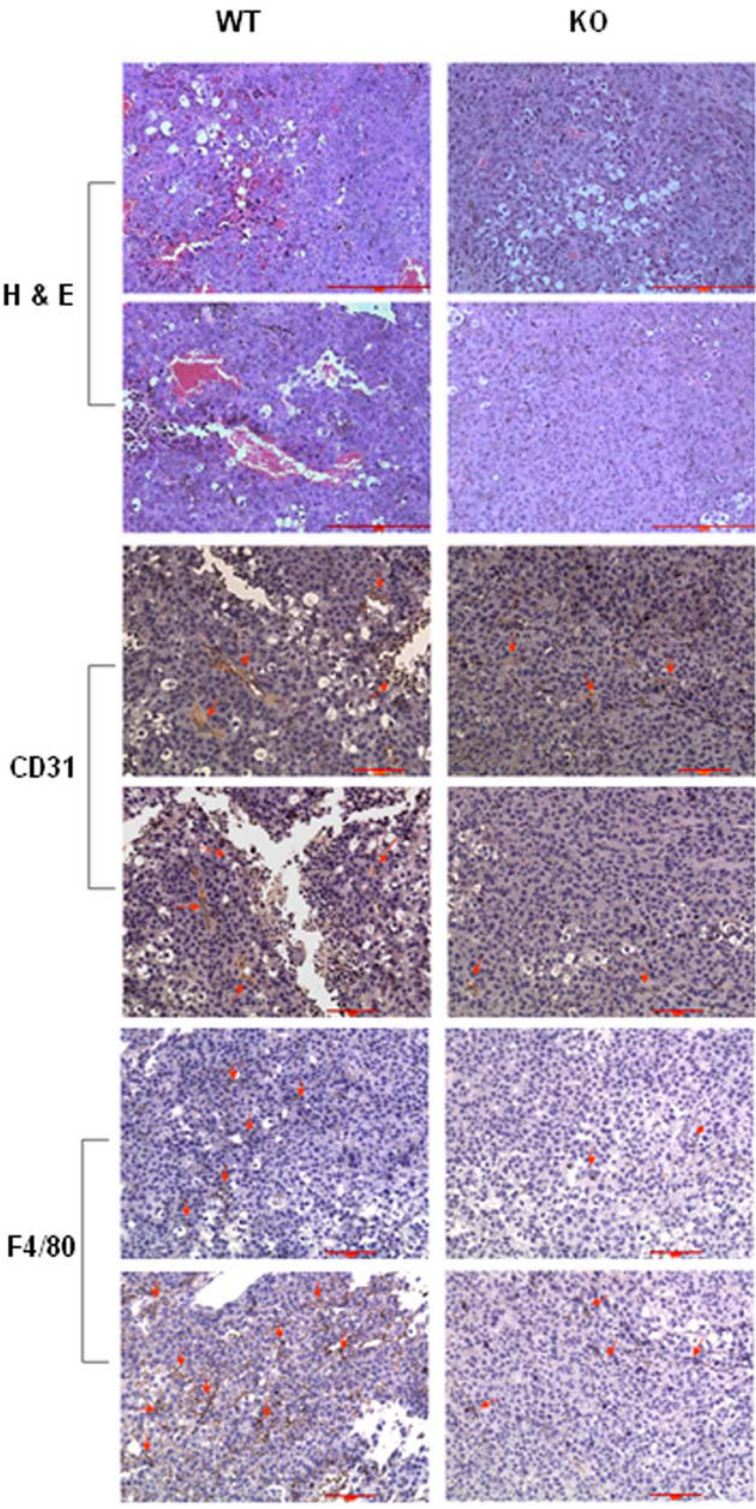
Figure 11. Immunohistochemistry staining of melanoma tissue from WT and KO mice. H & E staining of tumor sections for gross observation. Staining of tumor section with anti-CD31 (1:50) for angiogenesis analysis. Staining of tumor section with anti-F4/80 (1:75) to view macrophage infiltration. Representative positively stained cells were indicated by arrows. Scale bar=100 m m.